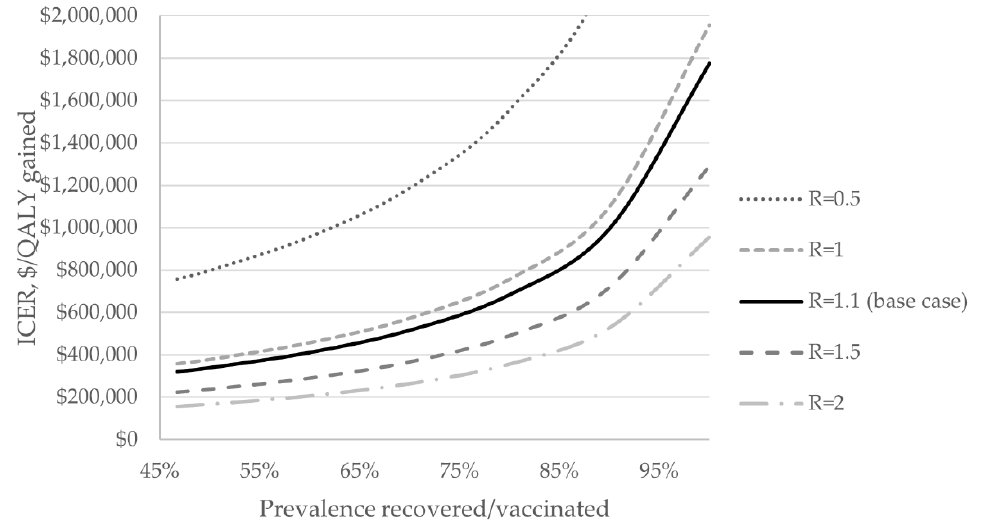
Figure 3. 2-way sensitivity analysis on the ICER for once weekly antigen testing with confirmatory PCR compared to no test. Figure capped at USD 2 million per QALY gained. Ag: antigen test, ICER: ncremental cost-effectiveness ratio, PCR: polymerase chain reaction test, R = effective reproduction number.